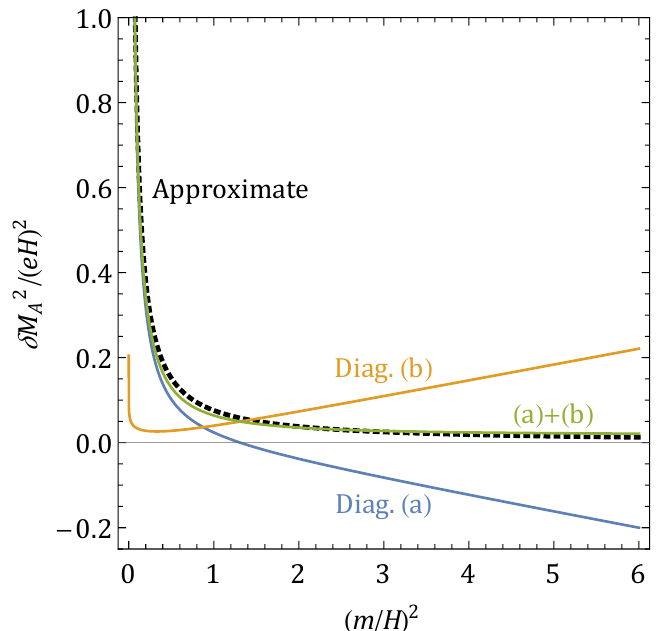
Figure 1 . The 1-loop mass corrections to the gauge boson (cid:14)M 2 loop scalar (cid:12)eld m 2 . The blue, orange, and green curves correspond to the mass corrections from diagram (2.21a) [given by eq. (2.24)], diagram (2.21b) [given by eq. (2.32)], and the sum of the two, respectively. The dashed line is the approximation eq.